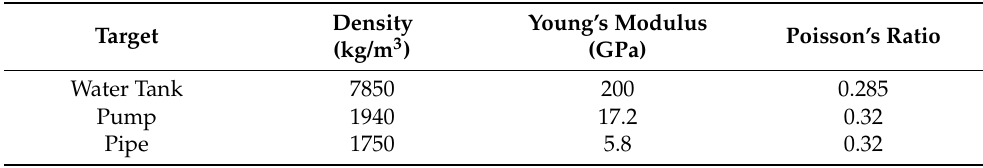
Table 1. Material properties of the parts of the scrubber.